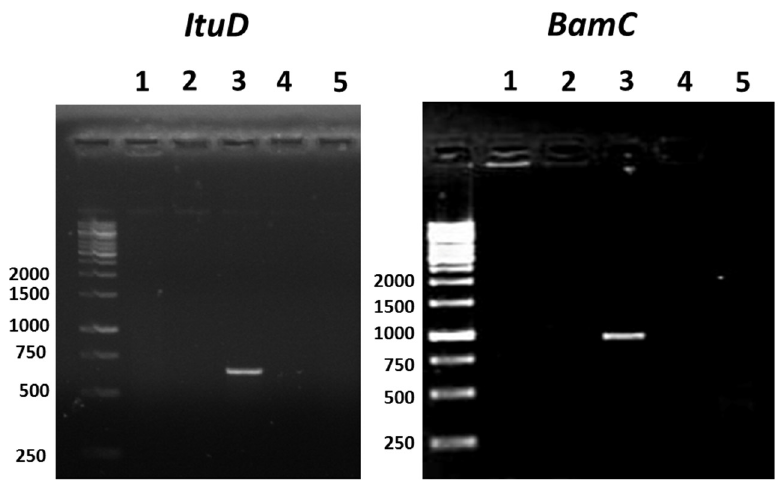
Figure 6. Bacillus subtilis strain R-11 shows sharp bands for ItuD and BamC genes in gel electrophoresis at 647 and 875, respectively. Lanes 1, 2, 3, 4 and 5 represent Bacillus licheniformis strain R-1, Bacillus pumilus strain R-4, Bacillus subtilis strain R-11, Bacillus haynesii strain R-19 and negative control, respectively; the molecular marker used is (GeneRuler 1 kb DNA Ladder, Thermo Fisher Scientific).